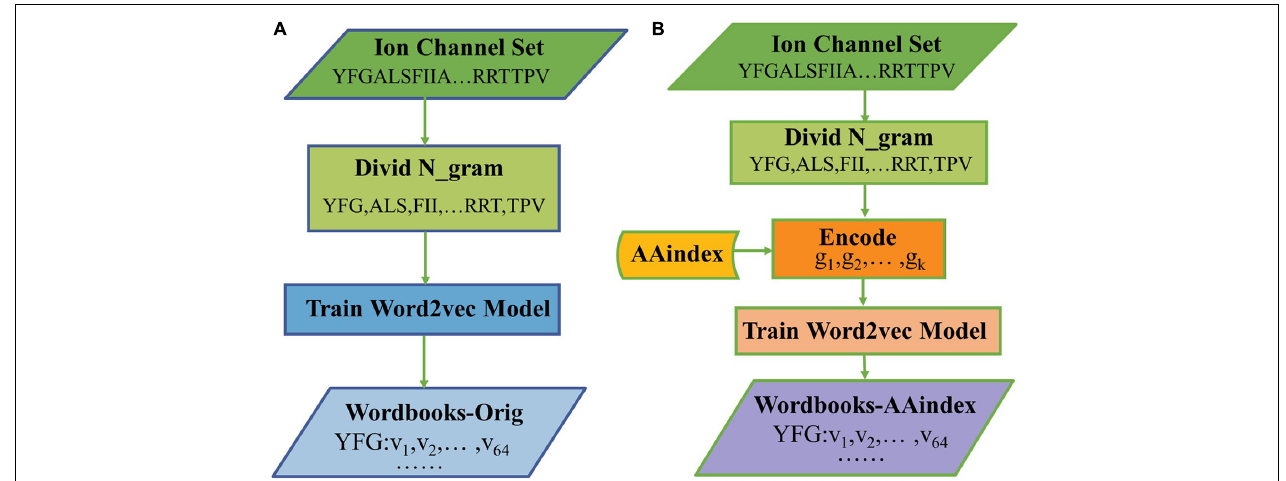
FIGURE 1 | The processes of constructed (A) Wordbooks-Orig and (B) Wordbooks-AAindex.